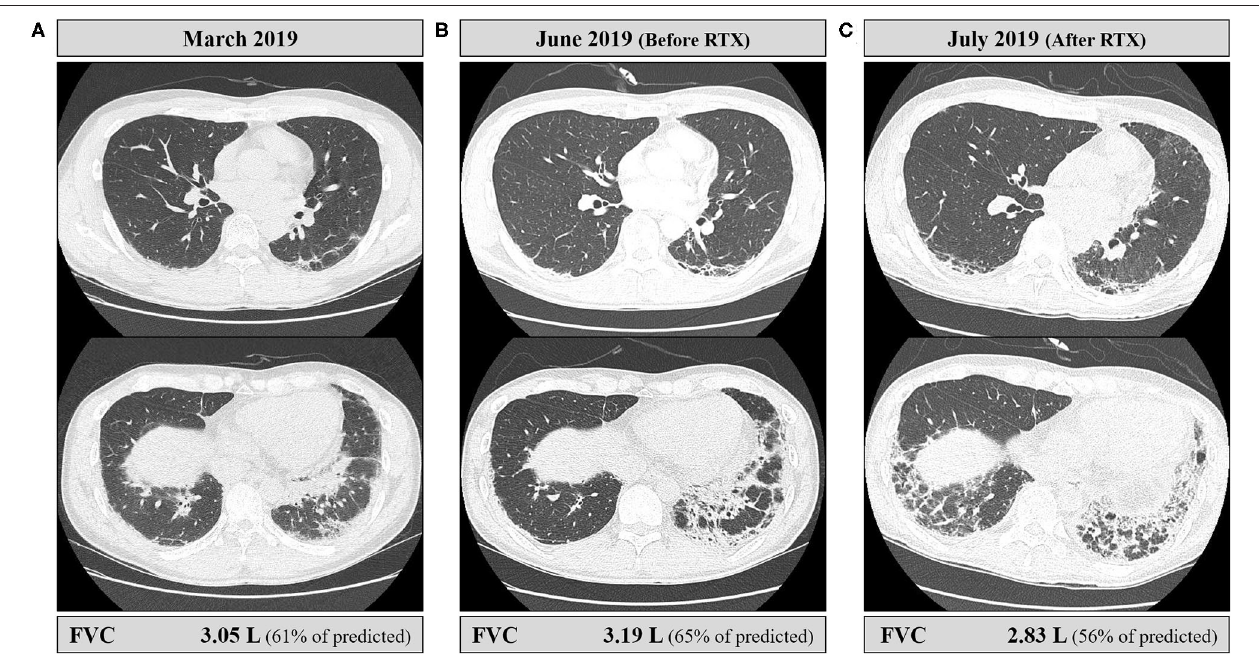
FIGURE 4 | Serial chest CT findings and pulmonary functions of the patient. (A) Initial CT at the time of diagnosis of ILD showed perilobular consolidations and fibrosis in posterior aspects of the lower lobes, and forced vital capacity (FVC) was 3.05L. (B) CT performed just before the rituximab injection showed the increased extent of fibrosis. However, the patient did not complain of respiratory symptoms including cough or dyspnea, and FVC was slightly improved by 4.6% compared to baseline. (C) CT performed immediately after the second rituximab injection showed an increased extent of fibrosis and perilobular consolidations. The patient developed mild dyspnea, and FVC declined by 11% from the latest